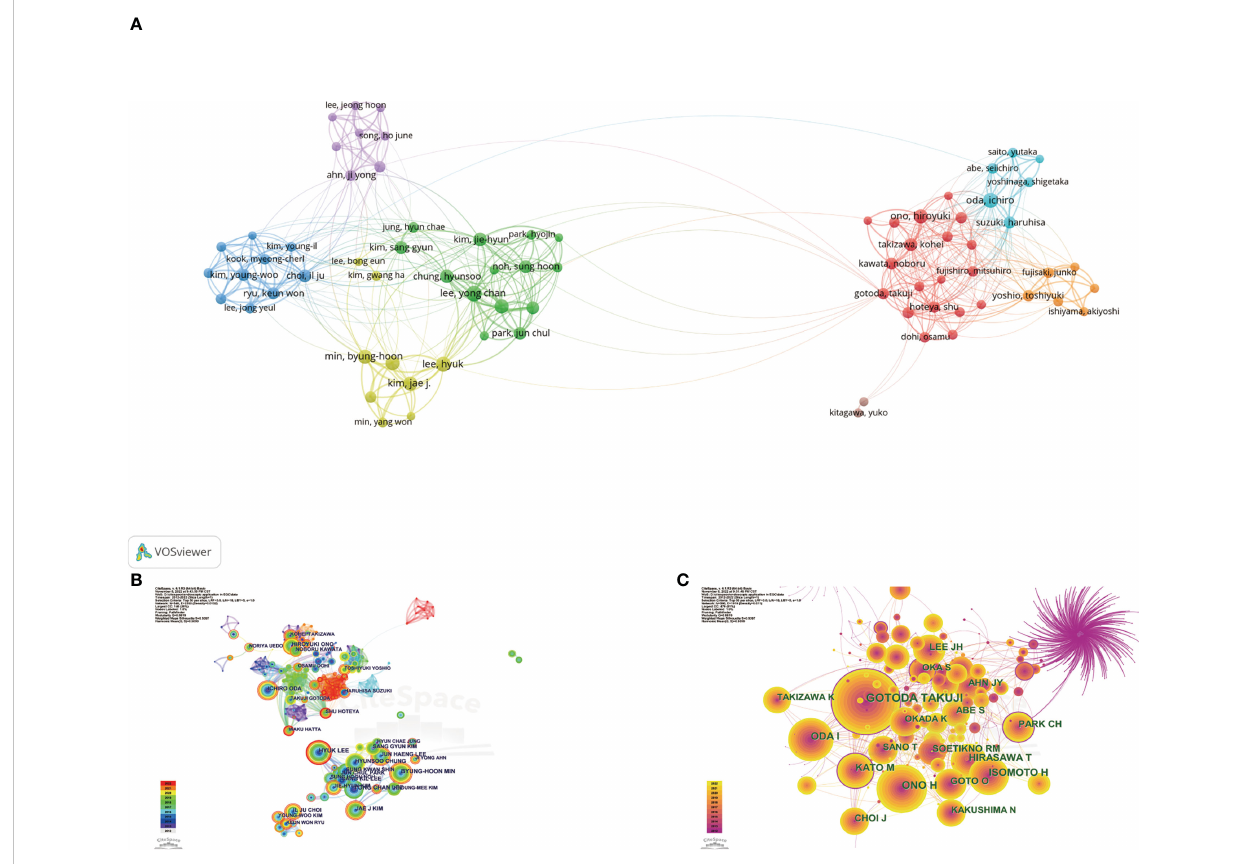
FIGURE 6 (A) Network visualization of the 79 "core authors" with each author had published at least 16 articles. (B) Network visualization map of authors collaboration analysis. Redder and thicker outer rings indicate more recent writing activity. (C) Network visualization map of cited authors collaboration analysis. Node size indicates citations, and high-centrality nodes have a purple